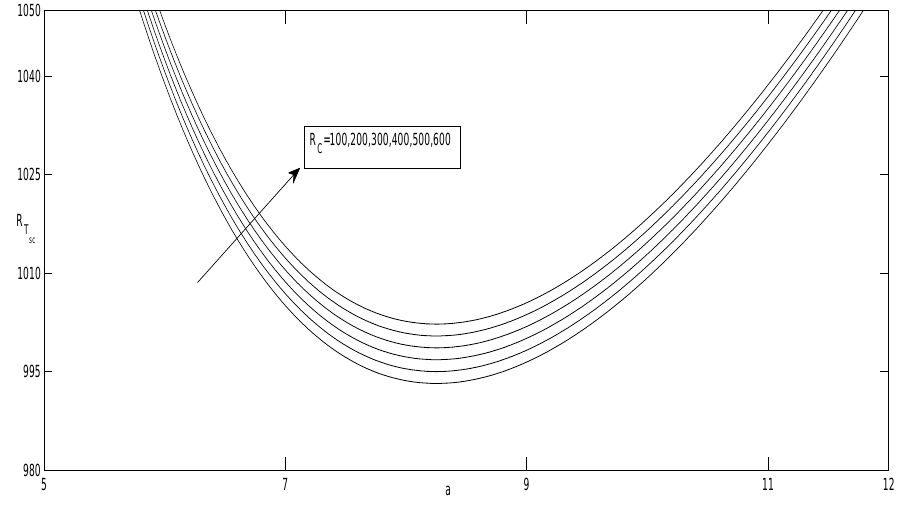
Figure 7. Neutral curves for the different values of R C and for the fixed values of γ = 0.5, η = 0.2, Ta = 50, and κ r = 1 for the oscillatory mode.